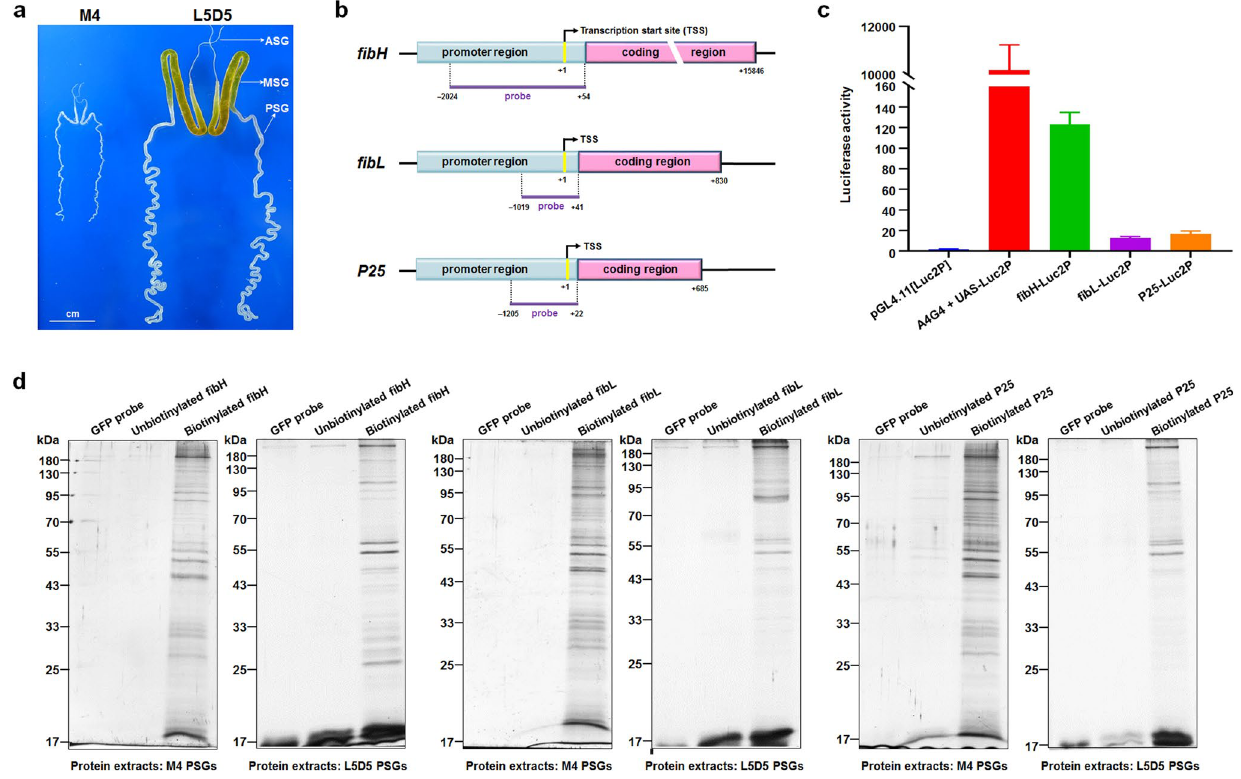
Figure 1. Probe design and DNA pull-down assay. ( a ) SGs dissected from silkworm larvae developed to M4 and L5D5. ( b ) Diagram of the fibroin genes fibH , fibL , and P25 and the locations of DNA probes. ( c ) Promoter activities of the fibH , fibL , and P25 genes measured by luciferase reporter assays. ( d ) Potential PIPs in PSG nuclear protein extracts were pulled down using the probes (full-length gels are presented in Supplementary Fig. S2). After SDS-PAGE and silver staining, the bound proteins were significantly enriched only in those groups in which 5’-biotinylated probes were